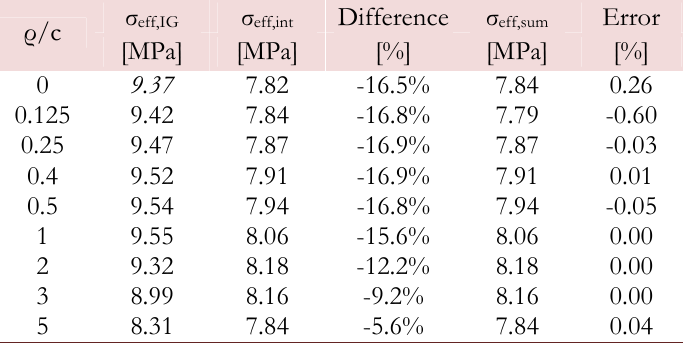
Table 3: Value of σ eff,IG , σ eff,int and σ eff,sum at any tested ratio.